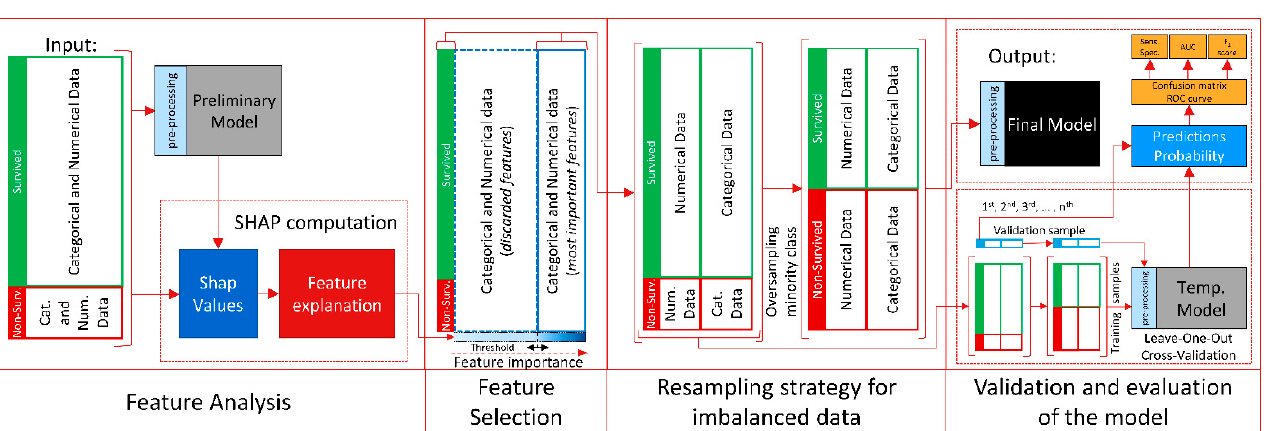
Figure 3. Diagram of the overall processing steps of the prediction model.